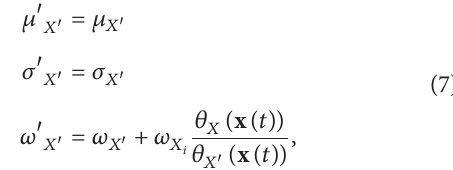
Figure 2 is the flow chart of